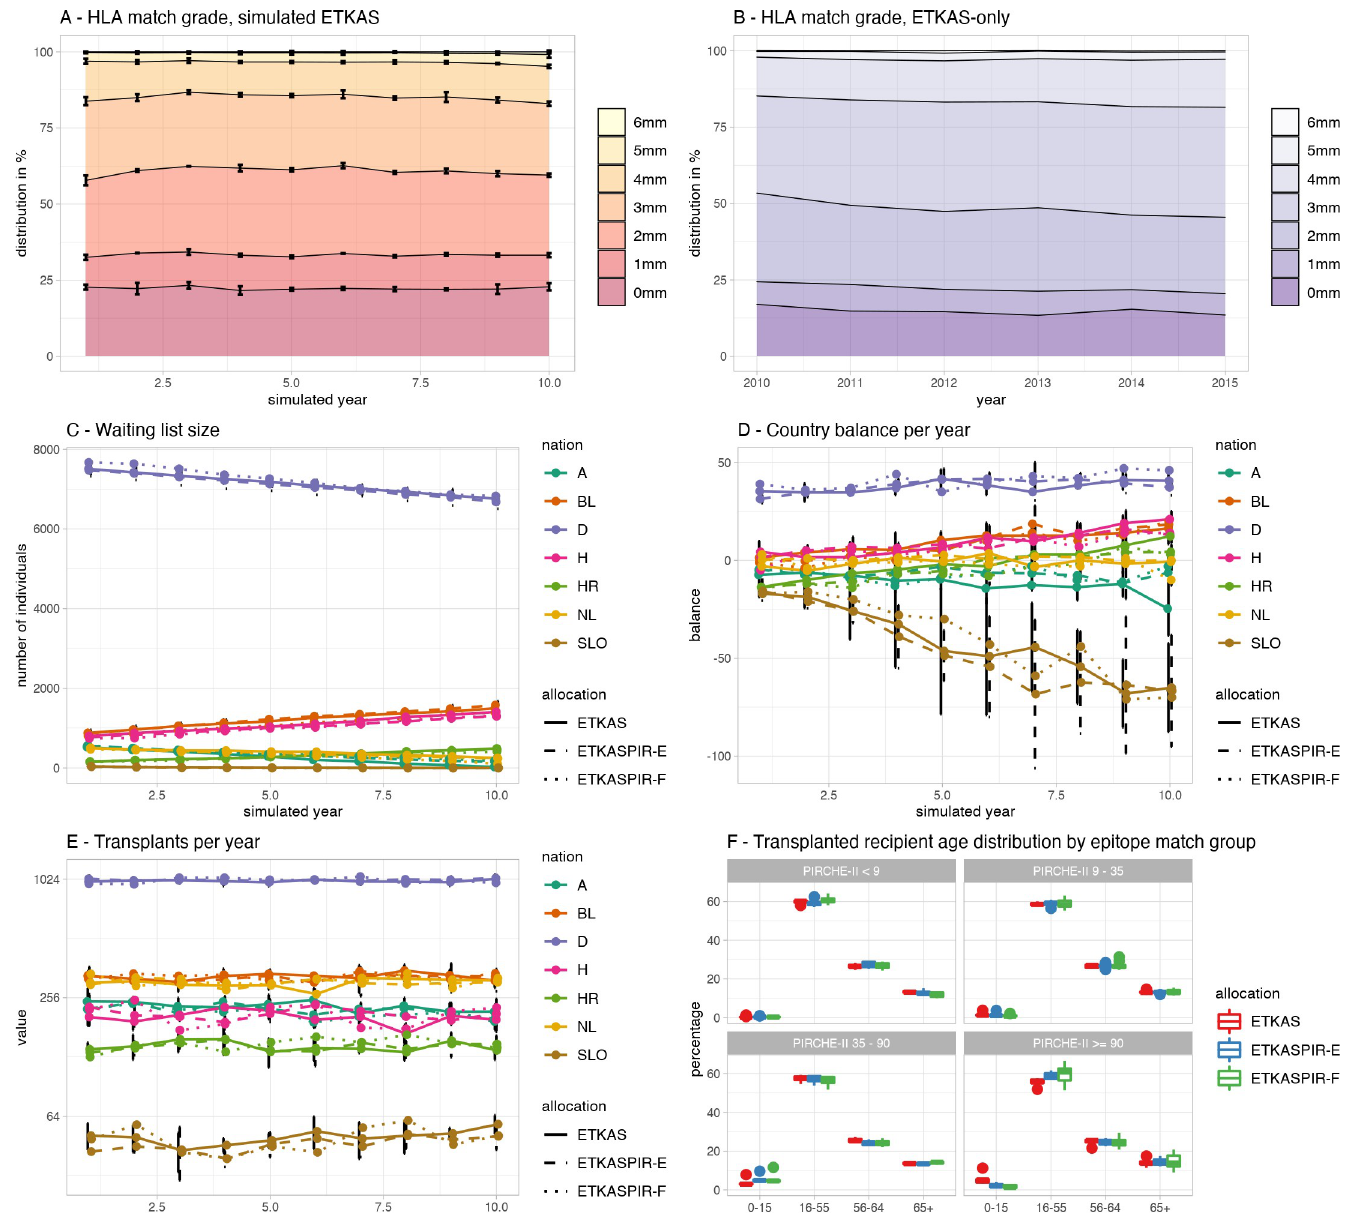
Fig 5. Simulation stability evaluation. (A) HLA match grade of the ETKAS simulations, year 10 compared to the 1998 observations: JSD = 0.069, p < 0.001, year 10 compared to 2015 ETKAS observations: JSD = 0.135, p < 0.001. (B) Observed HLA match grade reported by ET annual reports, only ETKAS. (C) Course of the distribution of the countries of origin of virtual individuals. (D) Course of country balance depending on country and simulated allocation models. (E) Number of transplants per country remained stable between the simulated allocations. (F) distribution of recipient age in the individual PIRCHE groups of different simulation